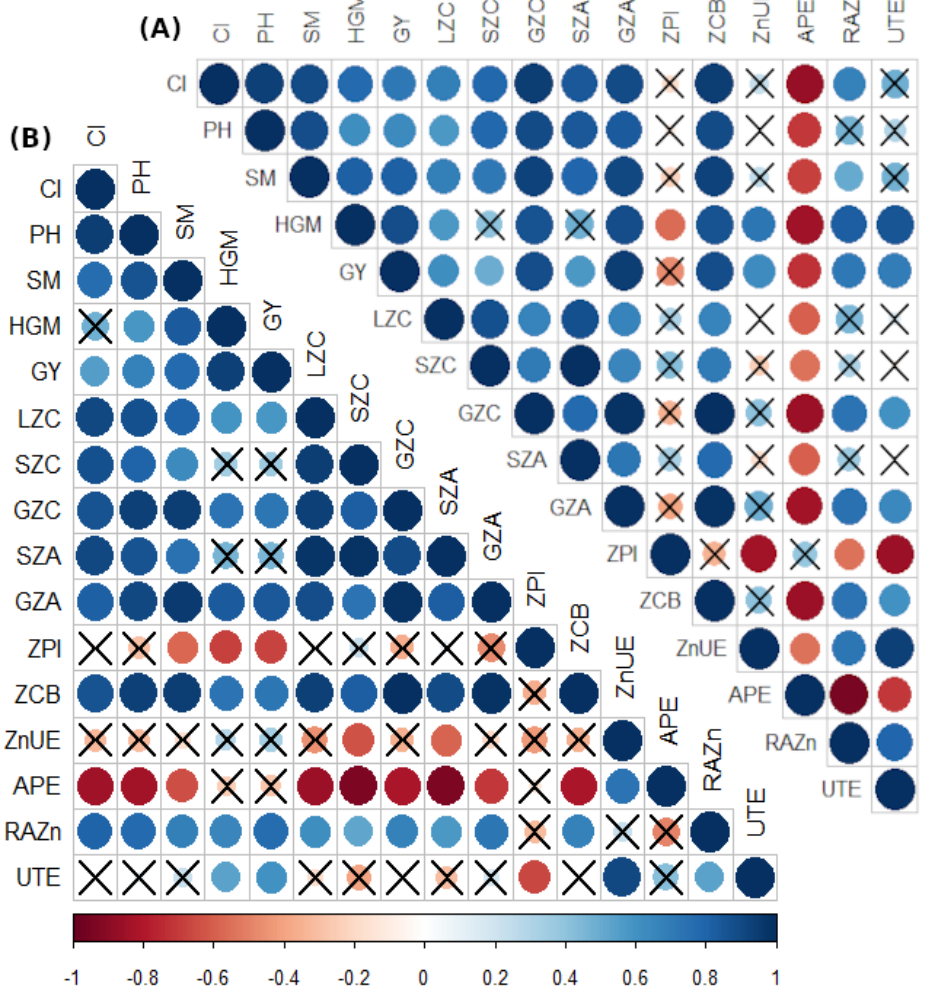
Figure 3. Heat-map color scale indicating Pearson’s correlation among evaluated parameters of maize plants in response to residual soil Zn applications and diazotrophic bacteria inoculations in 2019–2020 ( A ) and 2020–2021 ( B ) cropping seasons. * X = indicates a non-significant relationship ( p ≤ 0.05). Abbreviations: CI = Insertion of first productive cob, PH = plant height, SM = shoot dry matter, GY = grain yield, LZC = Leaf Zn concentration, SZC = Shoot Zn concentration, GZC = Grain Zn concentration, SZA = Shoot Zn accumulation, GZA = Grain Zn accumulation, ZPI = Zn partitioning index, ZCB = Zn intake in Brazil, ZnUE = Zn use efficiency, APE = Agro-physiological efficiency, RAZn = Applied Zn recovery, and UTE = Utilization efficiency.